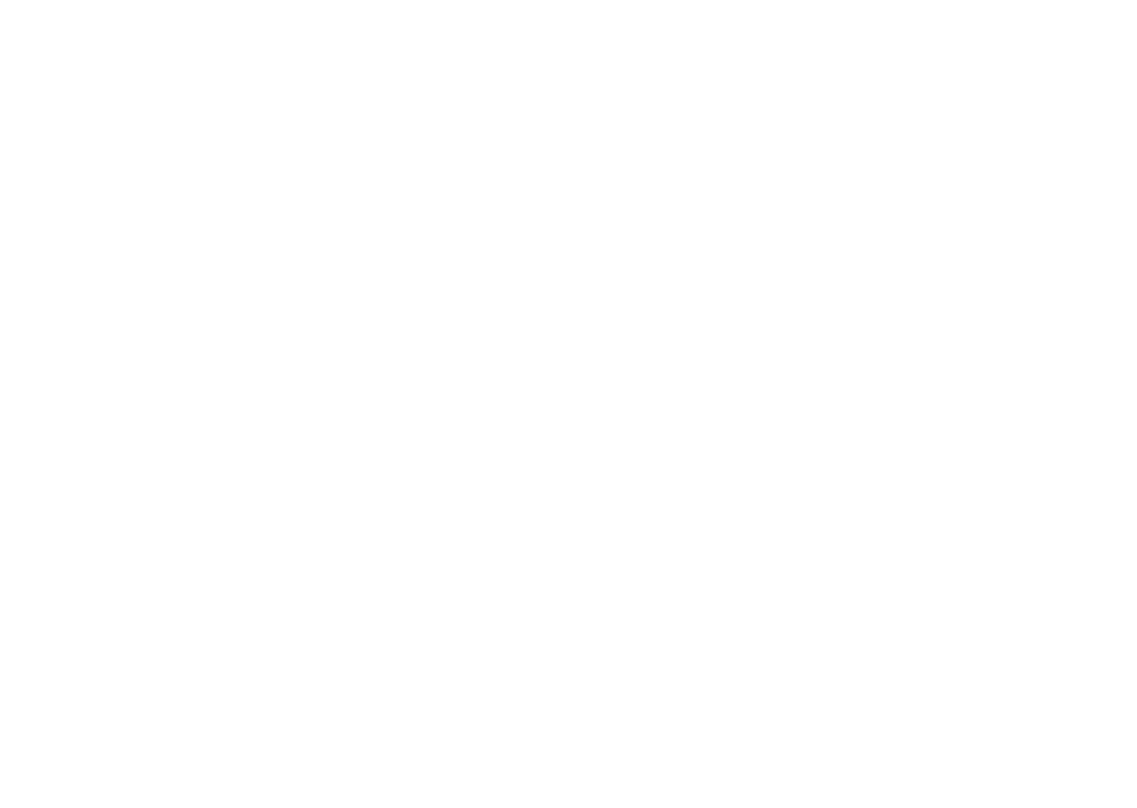
merged], or ( H ) the peroxisome marker 35S-DsRed<catalase [ (I) , merged]. Chlorophyll auto fluorescence is shown in each of the merged images (C,F,I) . Scale bars represent 50 μ m. CHL,